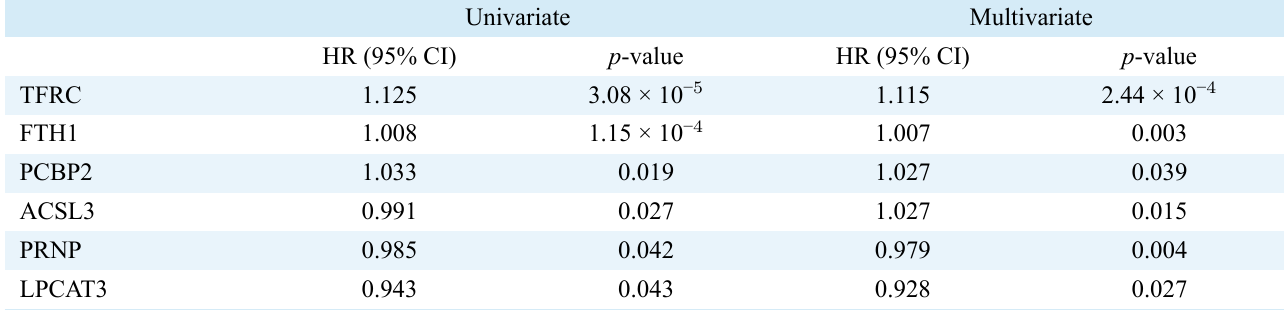
TABLE 1. Univariate and multivariate Cox regression analysis of 6 genes.